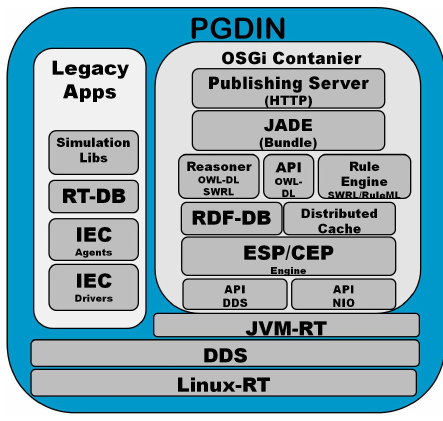
Figure 1. PGDIN design.